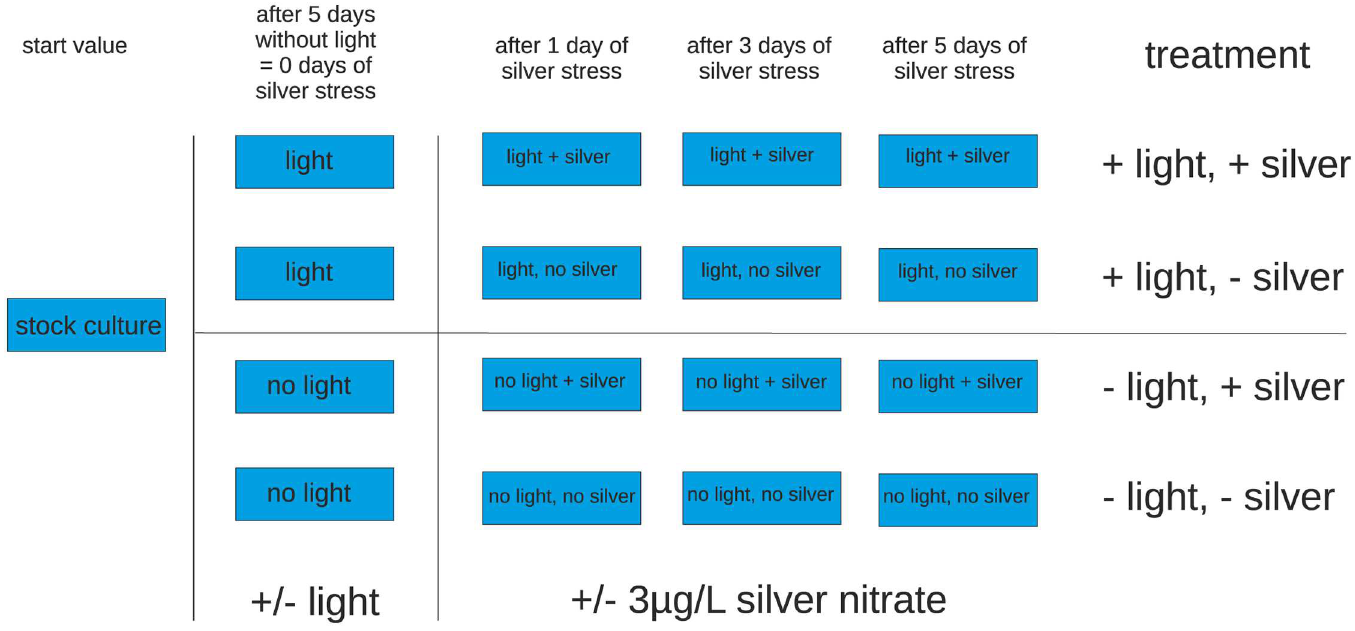
Fig 1. Experimental setup of light and silver nitrate exposure of cultures. The experiment was carried out in four different treatments, each treatment in four replicates(i.e. each blue box represents four replicates). First, light/no light was appliedfor 5 days. Then silver nitrate was added to two of the four treatments and sampleswere taken after 1, 3 and 5